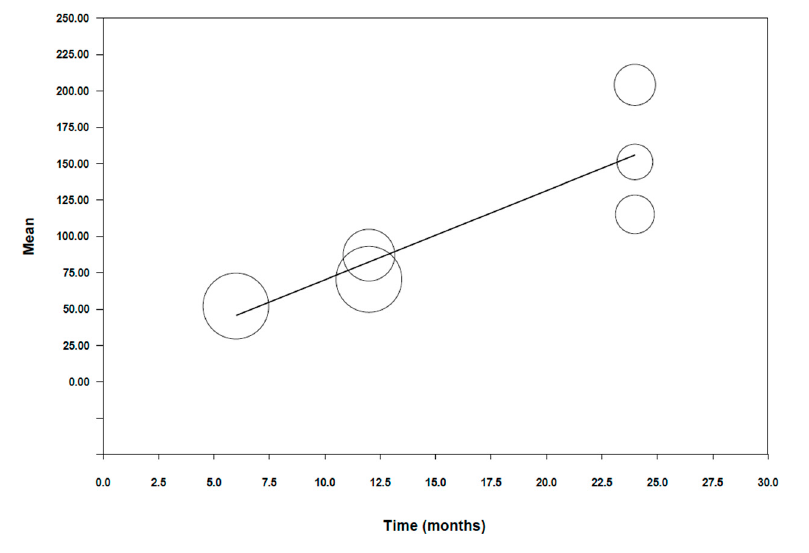
Figure 3. Graph depicting meta-regression of wear in the antagonist tooth vs. time.